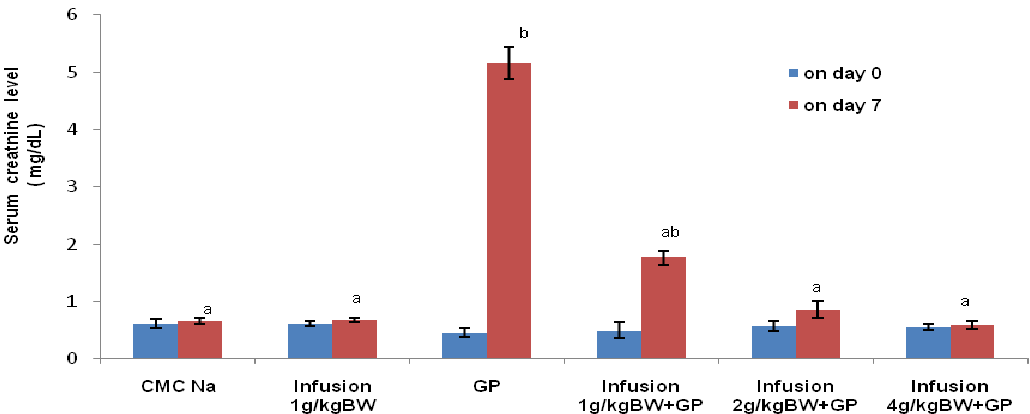
Figure 1 . Serum creatinine (mean±SD) on day 0 and after treatment of sarang semut infusion for 7 days in induced by gentamicin-piroxicam rats (GP) (n=5).